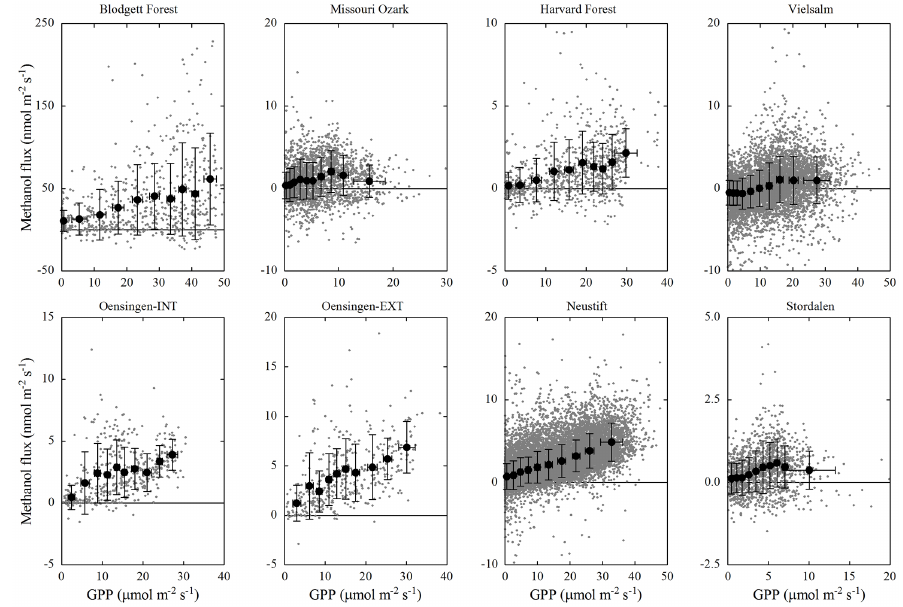
Figure 5. Relationship between gross photosynthesis (GPP) and methanol flux. Small grey symbols represent half-hourly flux measurements; black symbols represent 10 bin averages with equal numbers of data. Error bars refer to 1 standard deviation. Note different x and y scales in different panels.